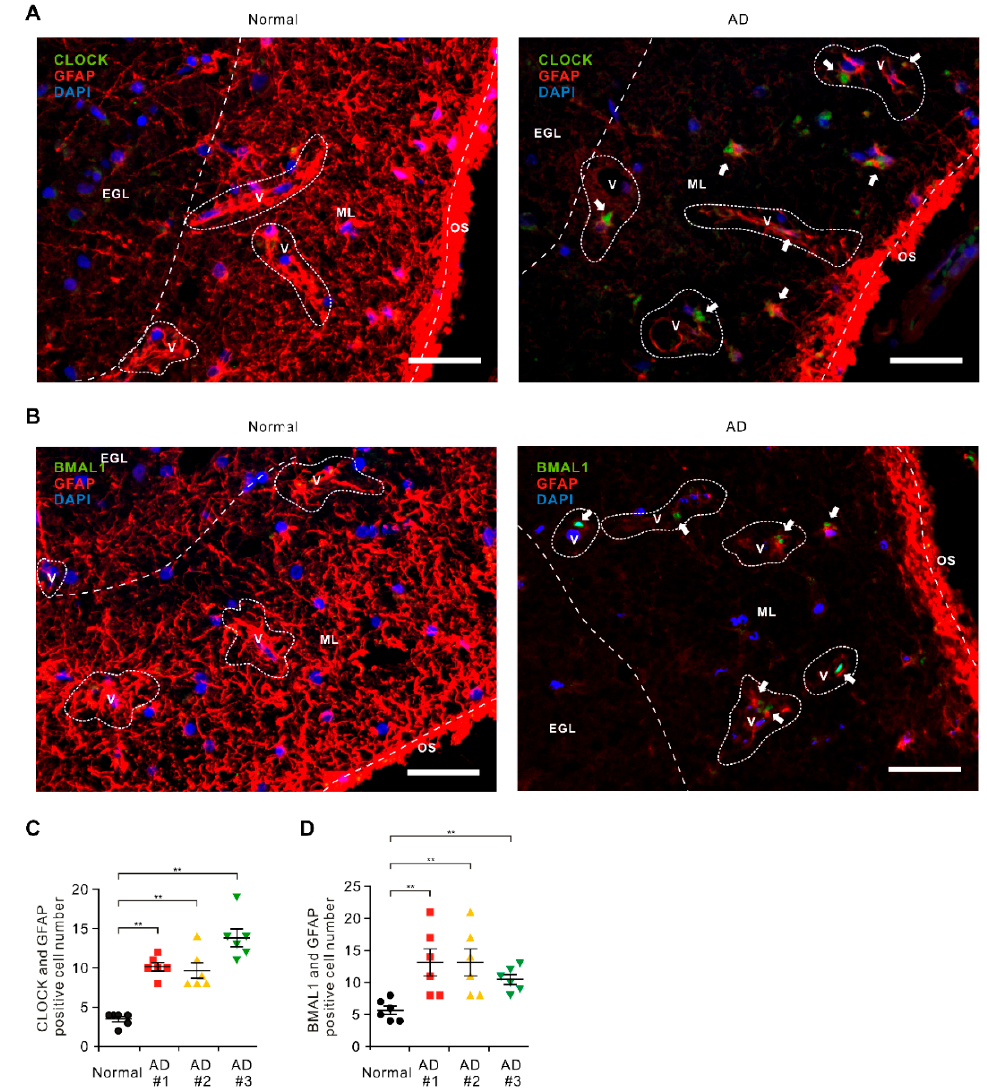
Figure 1. The levels of circadian locomotor output cycles kaput (CLOCK) and brain muscle ARNT-like1 (BMAL1) are elevated in impaired astrocytes in cerebral cortex region from patients with Alzheimer’s disease (AD). ( A ) Representative immunofluorescence images of CLOCK expression in cerebral